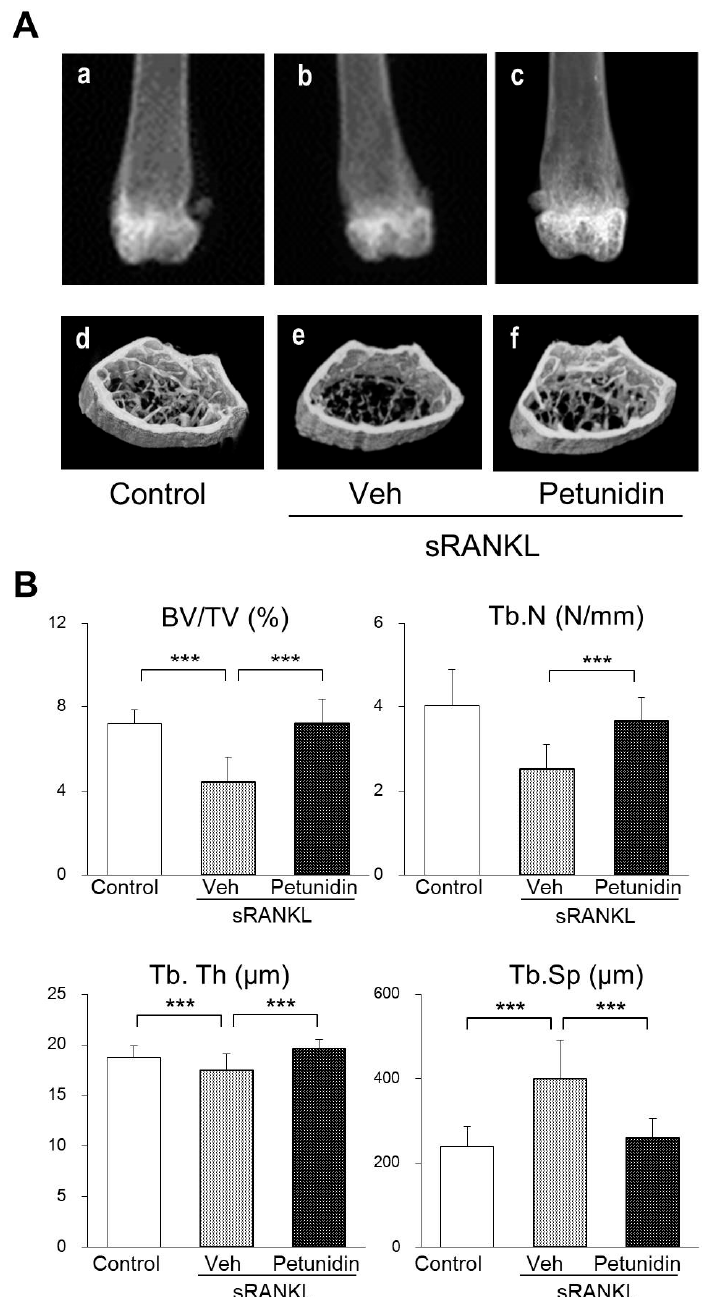
Figure 7. E ff ects of petunidin on bone loss in sRANKL-induced osteopenia mice. ( A ) Representative mouse (control), sRANKL-induced osteopenia mouse (Veh), and petunidin (7.5 mg / kg / day)-treated sRANKL-induced osteopenia mouse. ( B ) Microarchitectural indices of second trabecular spongiosa of the distal femurs as measured by micro-CT on the areas shown in Figure 7Ad–f. Values are expressed as the mean ± SD. *** p <